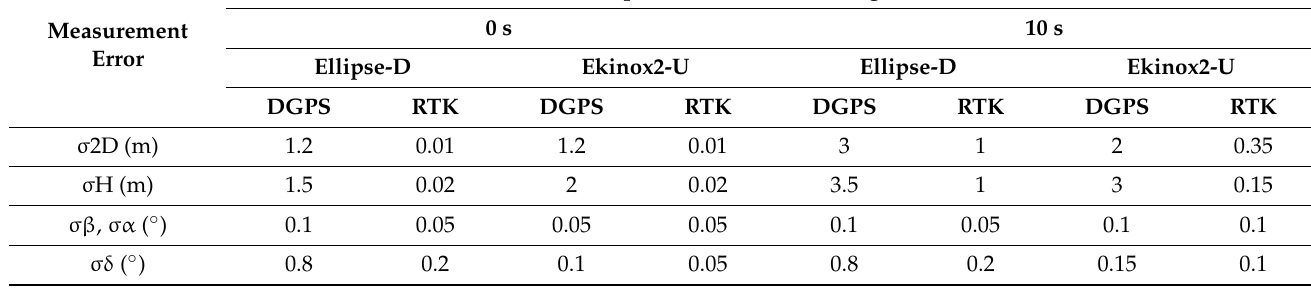
Table 1. Accuracy characteristics of the GNSS/INS systems, models Ekinox2-U and Ellipse-D in the case of access to and no access to a GNSS signal [75,76].